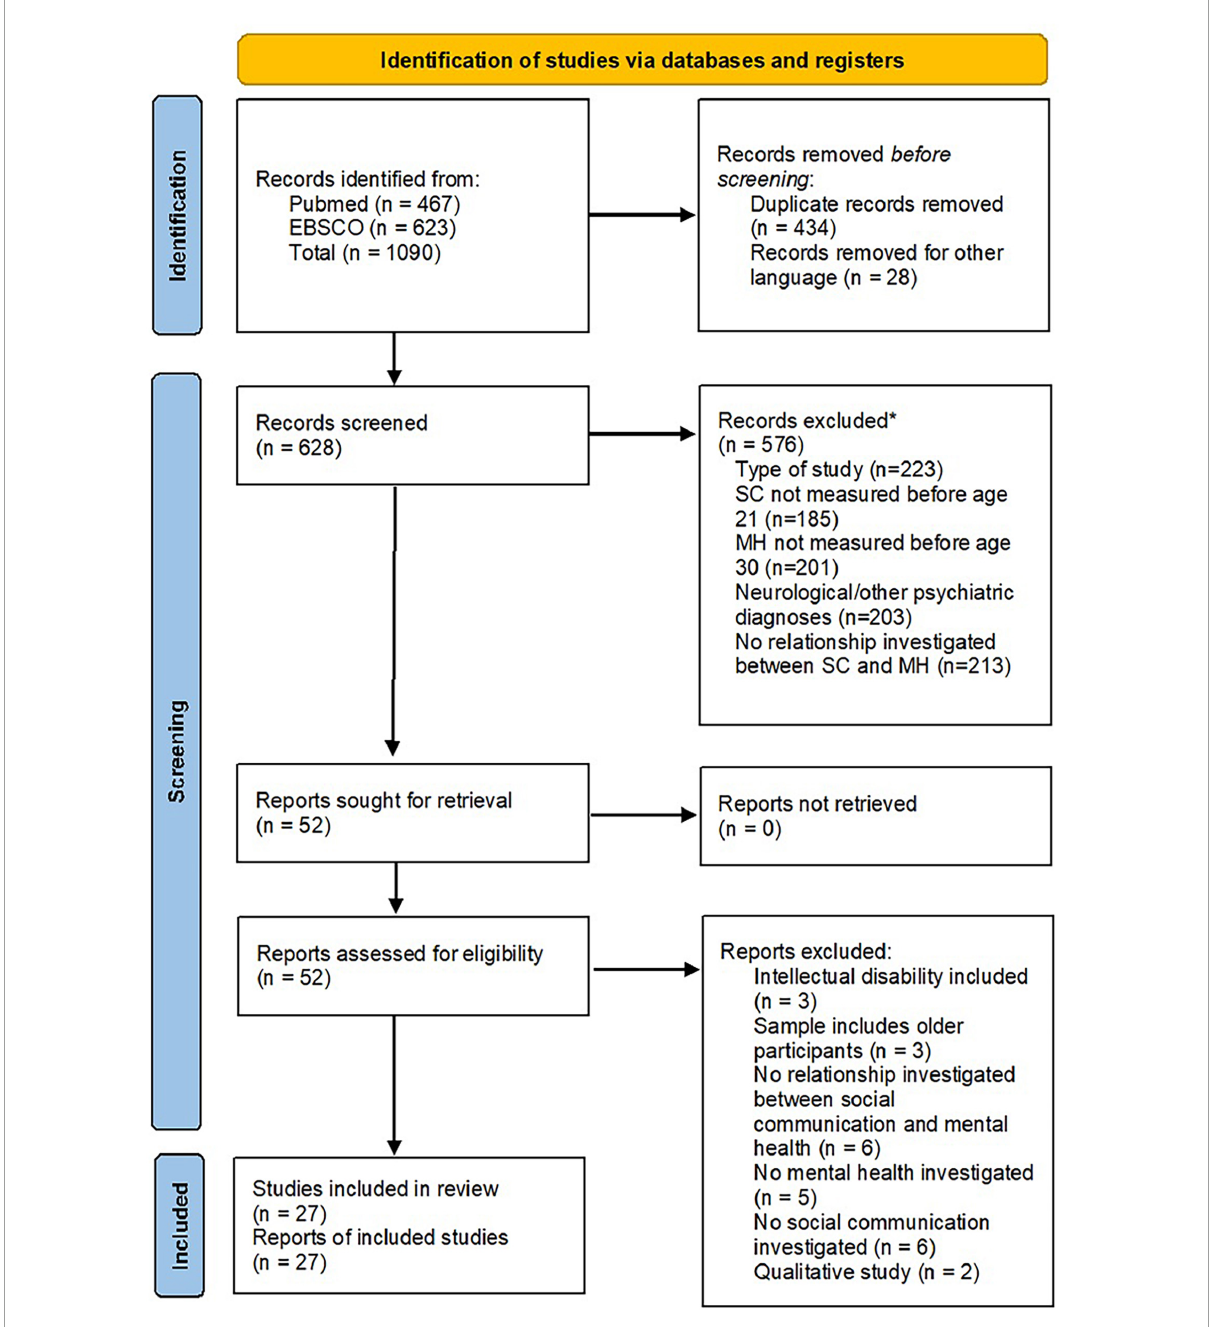
FIGURE2 Identification of studies of via databases and registers. *Publications could be excluded for more than one reason